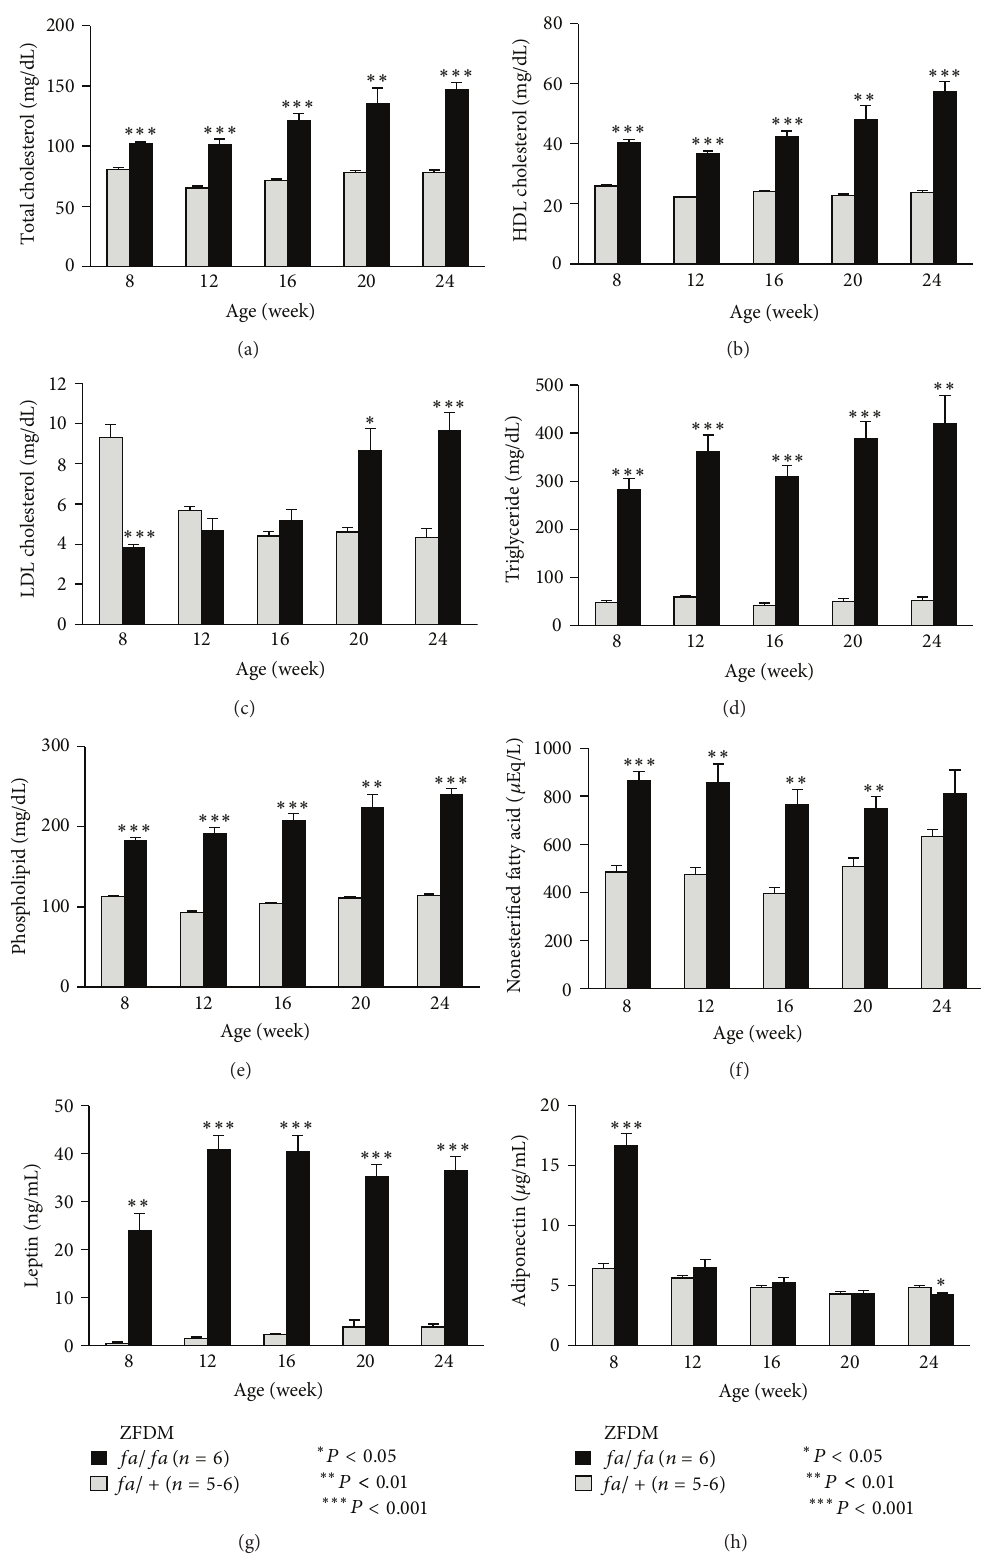
Figure 4: Serum lipid parameters and adipokines of the ZFDM strain. Fasting serum levels of (a) total cholesterol, (b) HDL cholesterol, (c) LDL cholesterol, (d) triglyceride, (e) phospholipid, (f) nonesterified fatty acid, (g) leptin, and (h) adiponectin of fa/fa ( 𝑛 = 6 ) and fa/ + ( 𝑛 = 6 , 6, 5, 5, and 6 for 8, 12, 16, 20, and 24 weeks of age, resp.) male rats in the ZFDM strain. Welch’s t test was used for comparisons between fa/fa and fa/ +